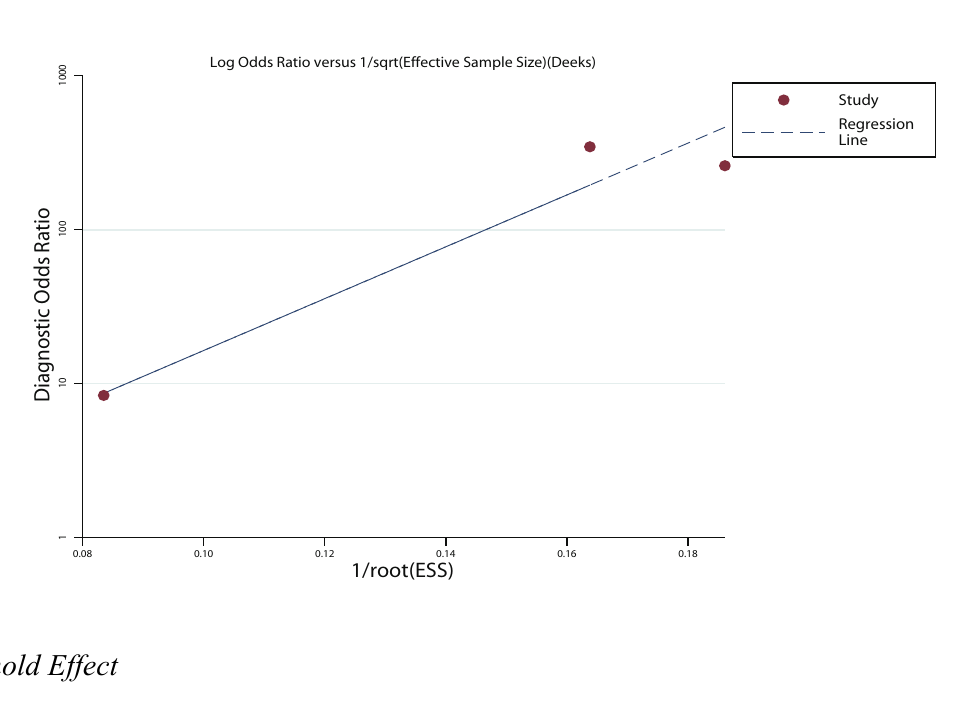
Figure 4. Funnel plot for the assessment of potential bias in miR-155